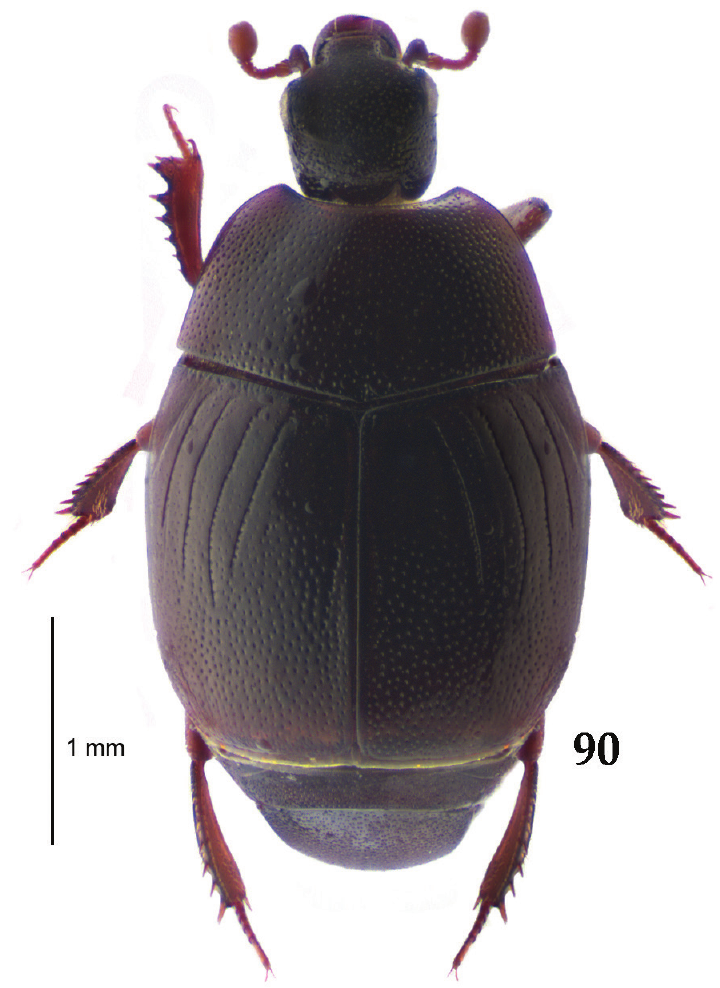
Figure 90. Gnathoncus rotundatus (Kugelann, 1792) habitus, dorsal view.